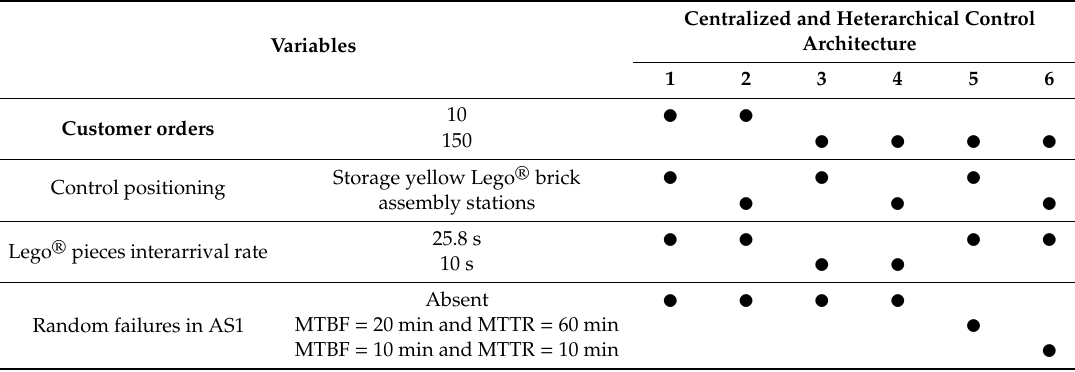
Table 2. Lego ® simulation model parameters.